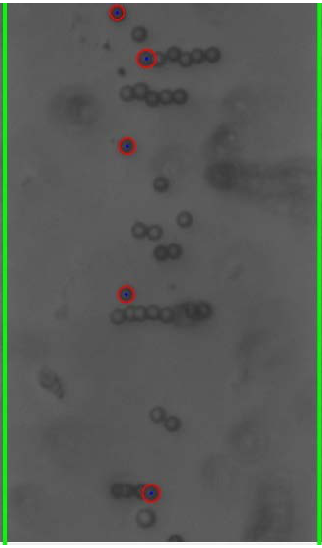
Figure 12. Pearl chain formation as a result of bead-to-bead interaction.